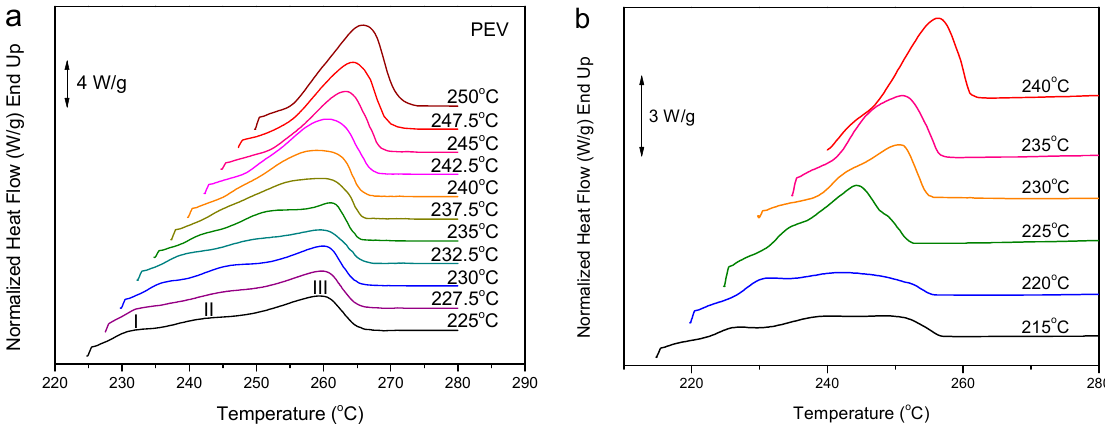
Figure 8. Subsequent DSC heating scans at 20 °C/min after self-nucleated isothermal crystallization at the indicated temperatures for ( a ) lower M w and ( b ) higher M w PEV sample.